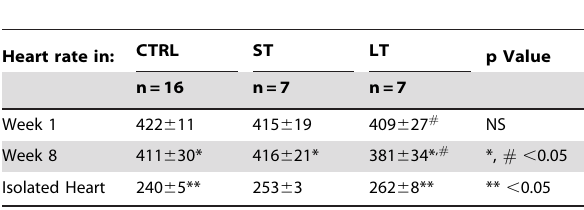
Table 4. Heart rate (bpm) at the the different phase of the